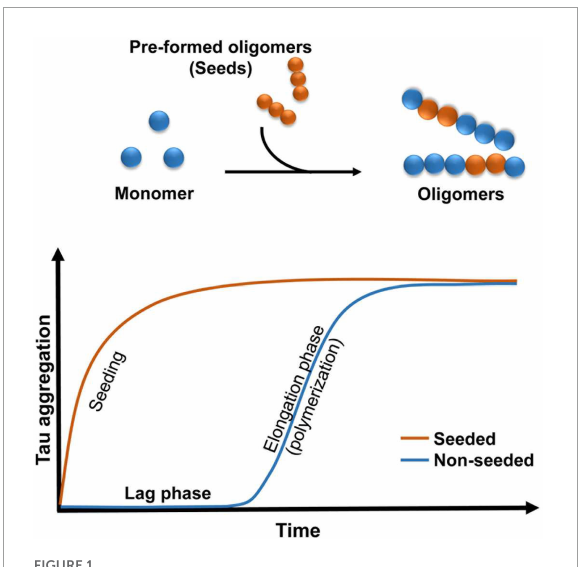
FIGURE1 Schematic illustrating the kinetics of oligomers formation. Addition of pre-formed oligomers reduced the lag phase.